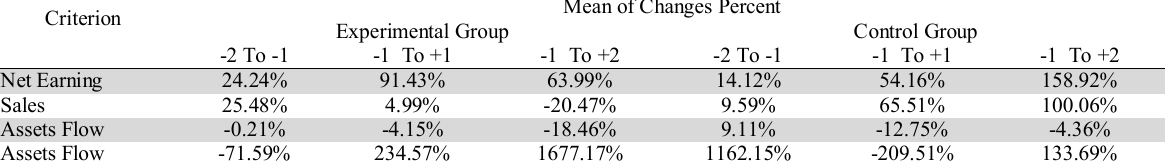
Fig. 2. The trend on operational earnings Net Earnings and Operational Indices Changes for Experimental and Control Group